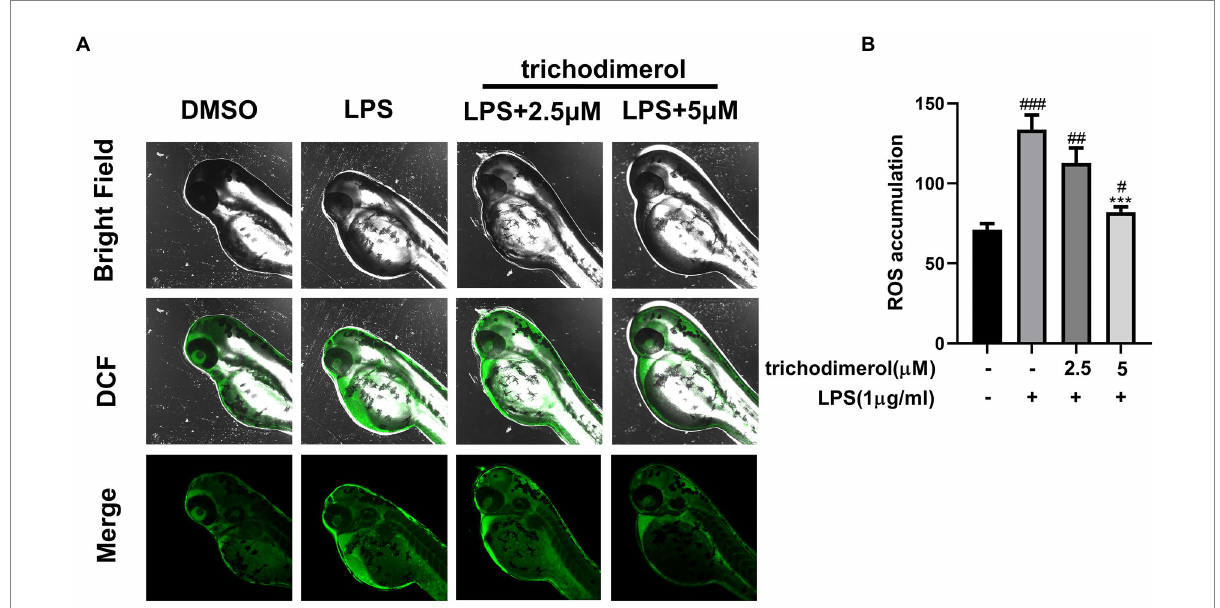
FIGURE 4 The accumulation of ROS in zebrafish. (A) Images of reactive oxygen species (ROS) levels in zebrafish exposed to different amounts of trichodimerol. Green fluorescence represents intracellular ROS stained by DCFH-DA. (B) ImageJ was used to quantify the fluorescence intensity, which was statistically analyzed. All data are expressed as the mean ± SD. # p < 0.05, ## p < 0.01, and ### p < 0.001, compared with the DMSO group. *** p < 0.001, compared with the LPS group.